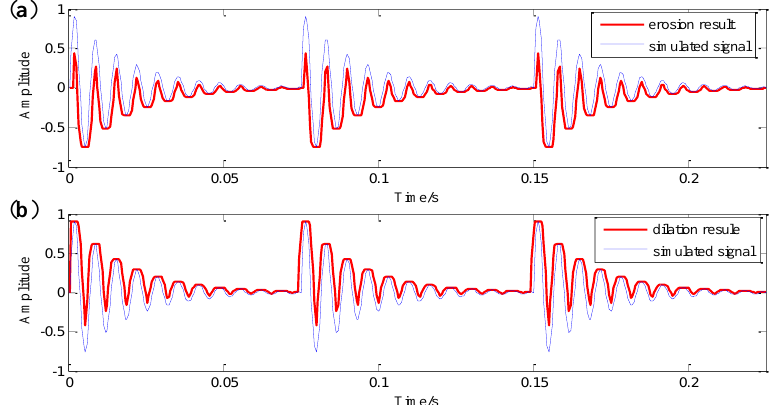
Figure 2. Filtering result of basic morphological operators: ( a ) erosion and ( b ) dilation.